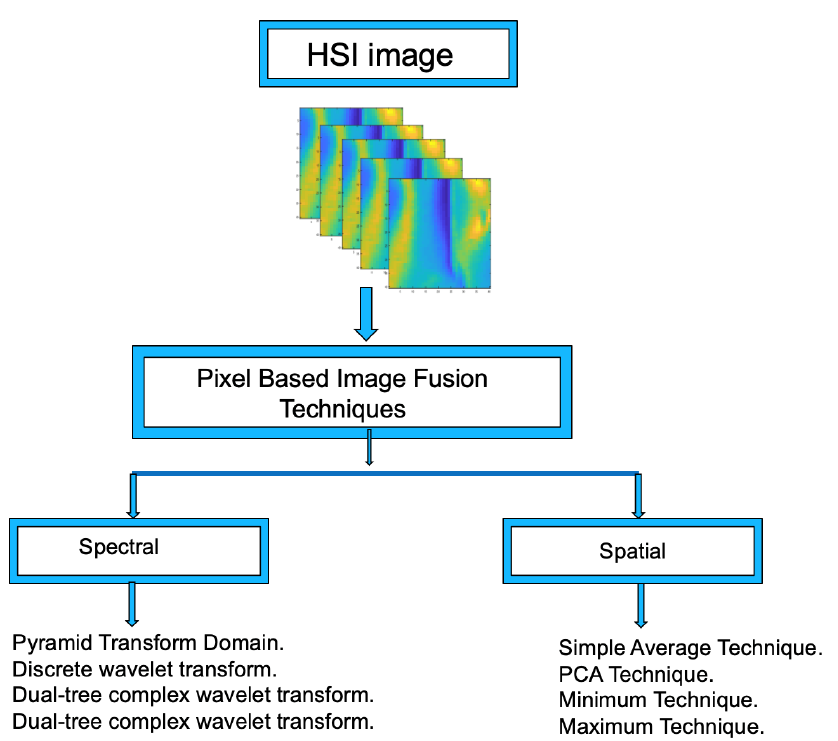
Figure 3. Spectral and spatial fusion methods used to reduce the number of hyperspectral data obtained from the HSI